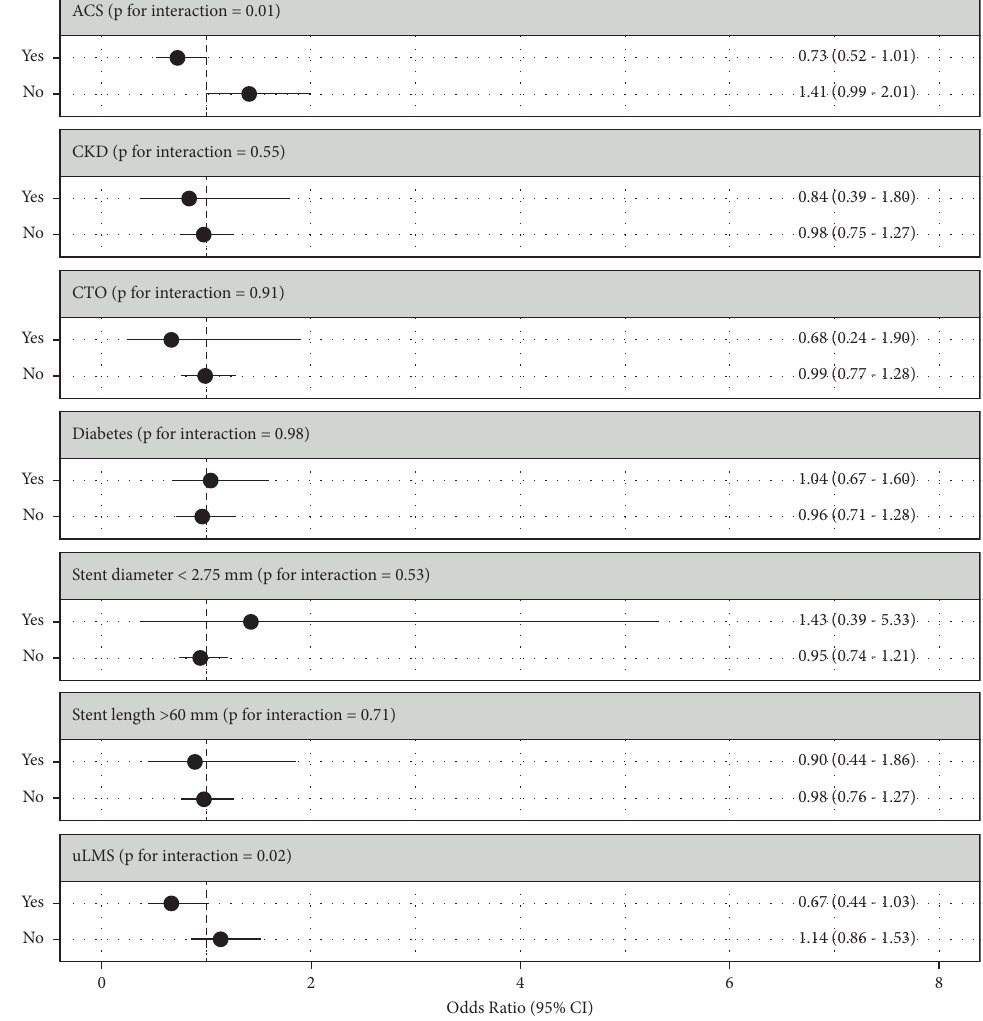
Supplementary Figure S1: consort flow diagram for study population. Supplementary Table S1: percentage of missing data in baseline, procedural, and outcome variables.